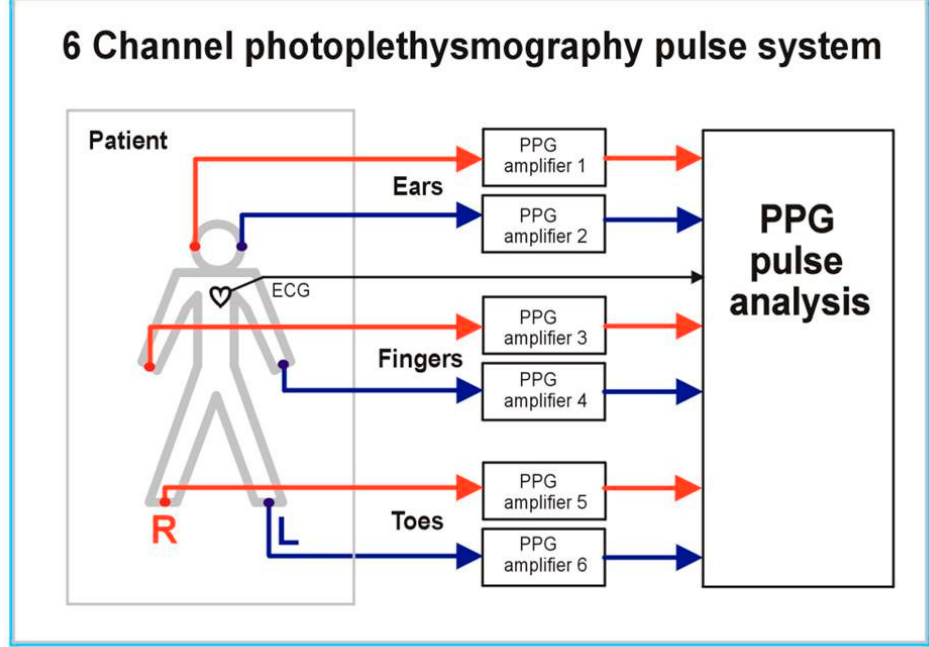
Figure 1. Multi-site photoplethysmography (PPG) pulse measurement and analysis system (from [1], with permission from IoP Publishing).